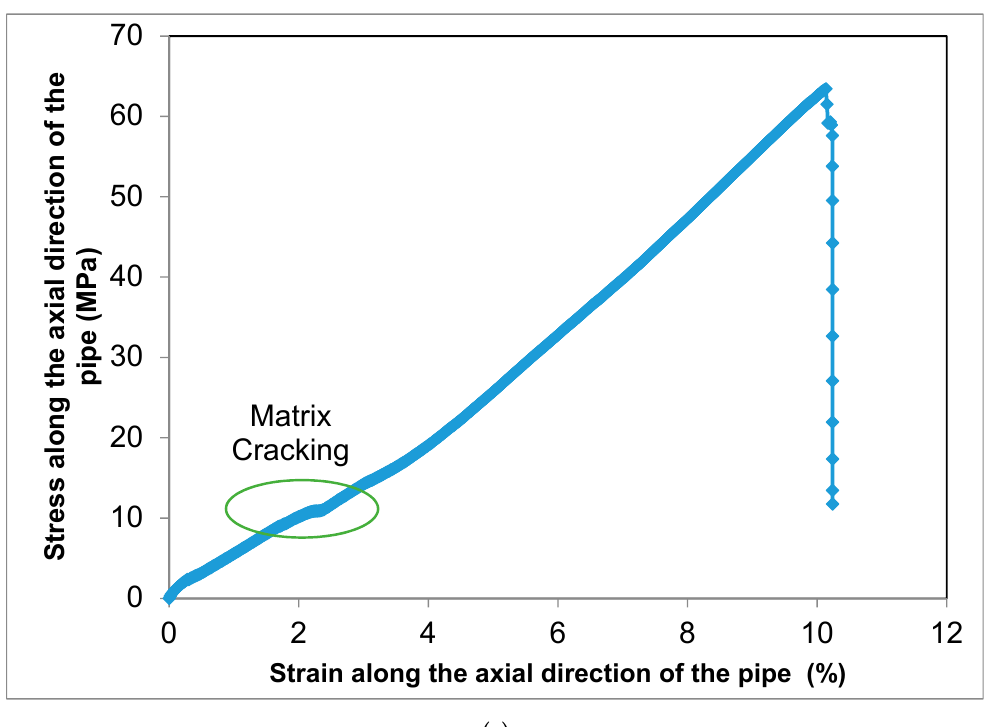
Strain along the axial direction of the pipe (%)